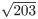
Modified Barabási-Albert networks.The network on the left was grown with λ = 0.1 to order n = 203. It has two hubs of degrees {15, 17} which exceed 203. The network on the right was grown with λ = 1.5 to order n = 172. This network contains hubs of degrees {15, 15, 16, 17, 19, 27, 33} exceeding 172. In both cases the algorithm was implemented with p = 0. The arrangement of nodes and bonds in these networks was created using the prefuse force directed lay-out in Cytoscape 3.4.0 [17].